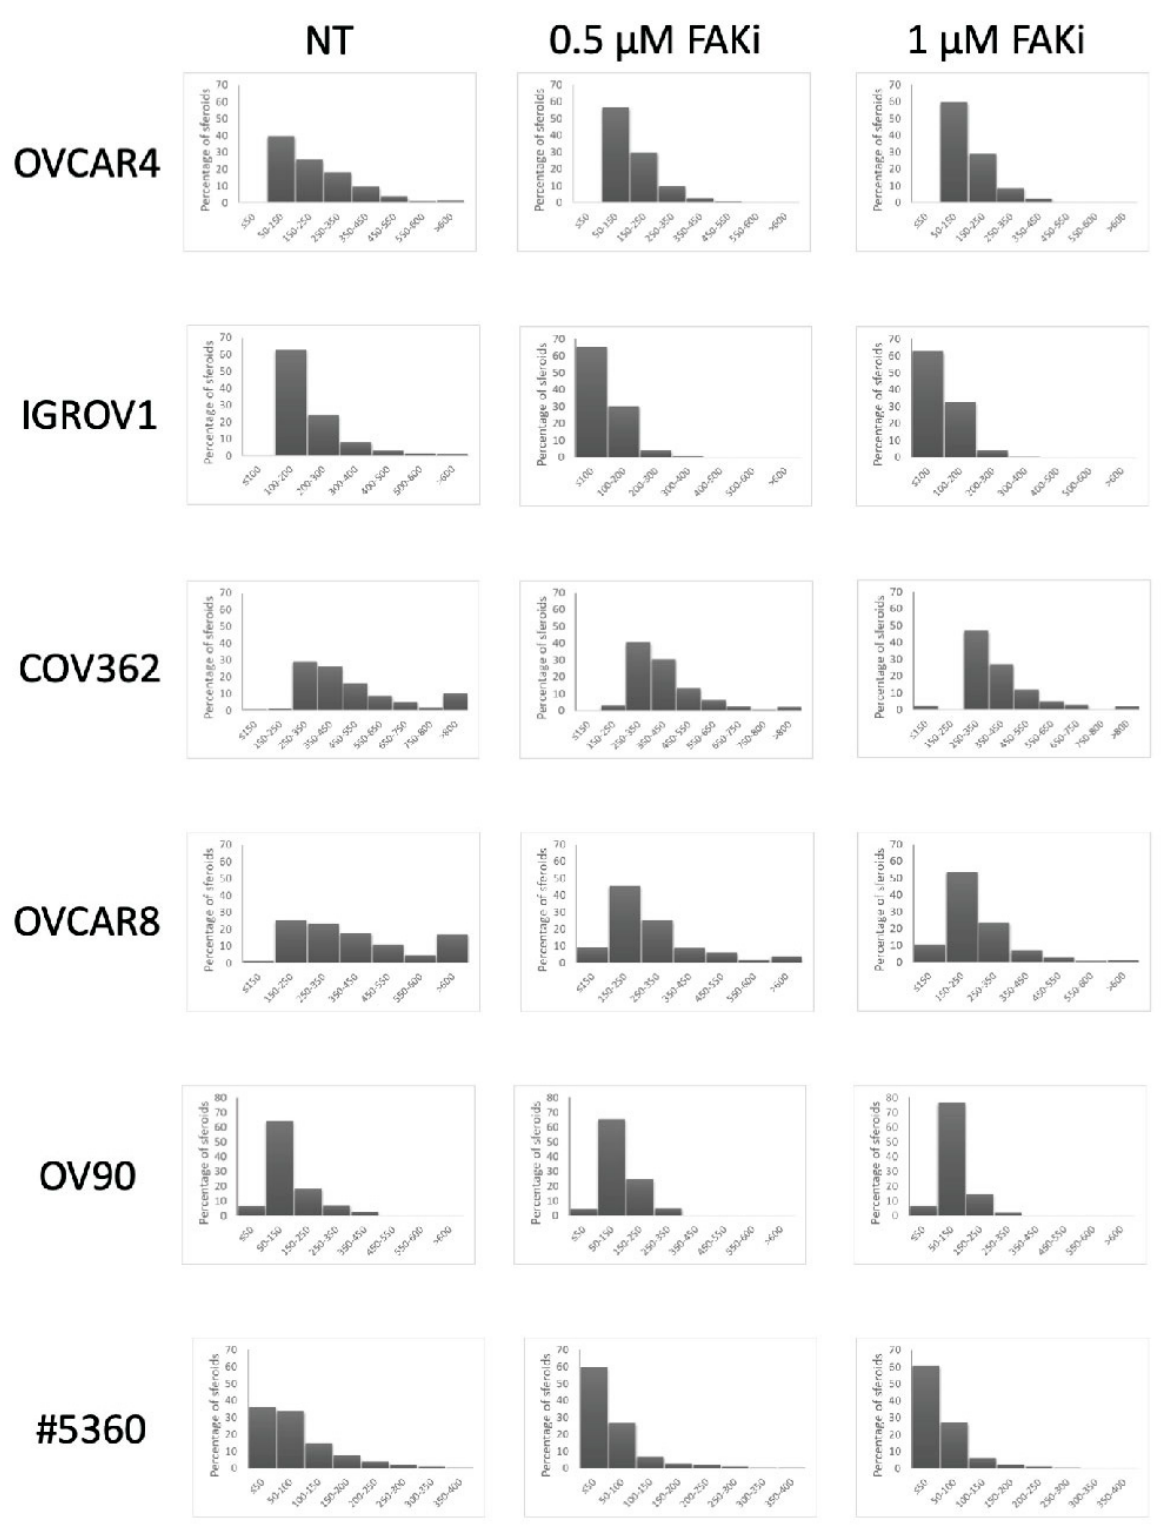
Figure 10. Feret diameter of the 3D aggregates formed by the listed ovarian cancer cell lines and of the spheroid of the bulk ascites sample #5360 grown for 5 days in the presence of the PDN-1186 FAK inhibitor (FAKi) at the indicated concentrations.